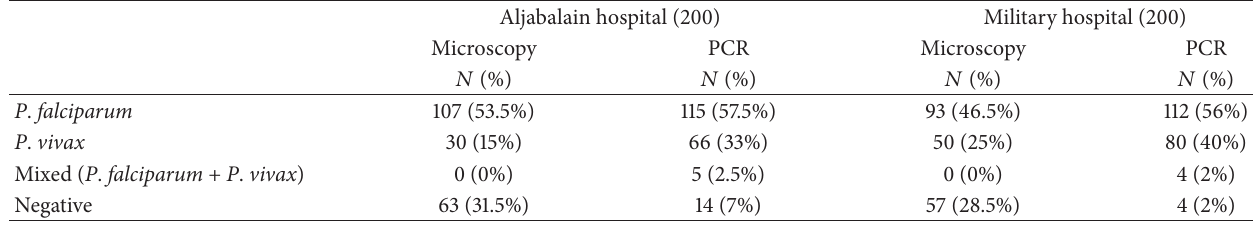
Table 2: Positive results of blood films and PCR for P . falciparum and P . vivax in Aljabalain hospital and military hospital.